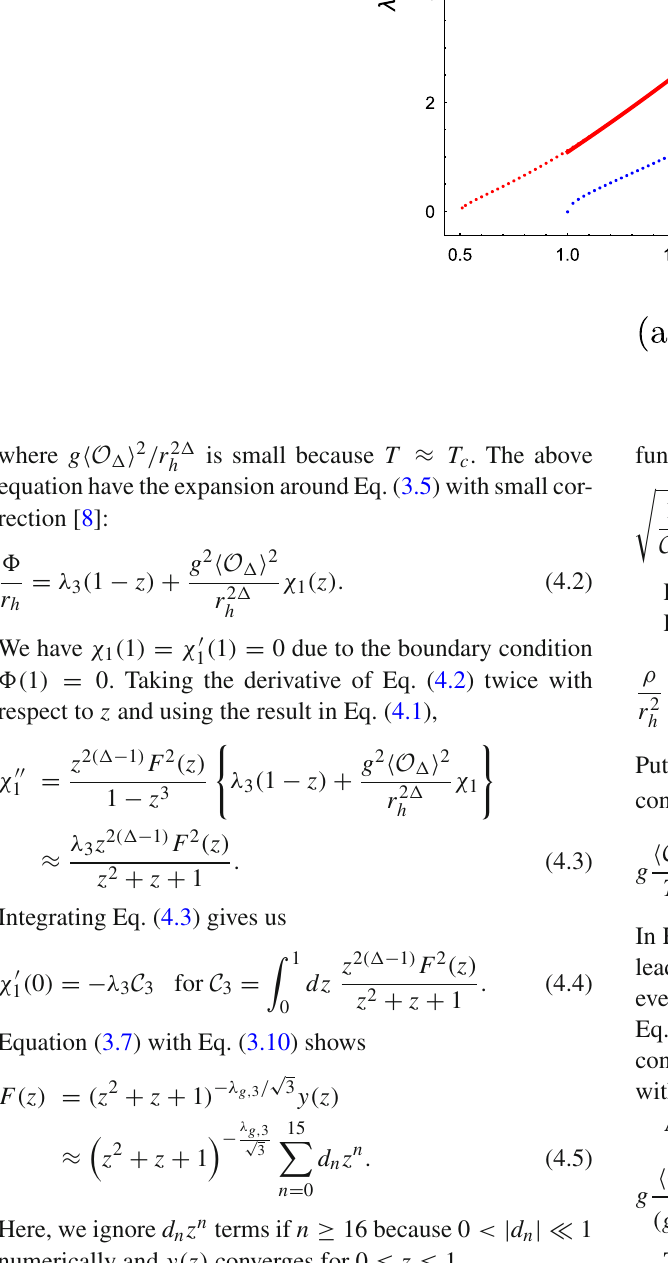
Fig. 3 λ g , d vs (cid:2) : red line for λ g , 3 and blue line for results of variational method in Ref. [8] is denoted by red and blue dotted lines for AdS 4 and AdS 5